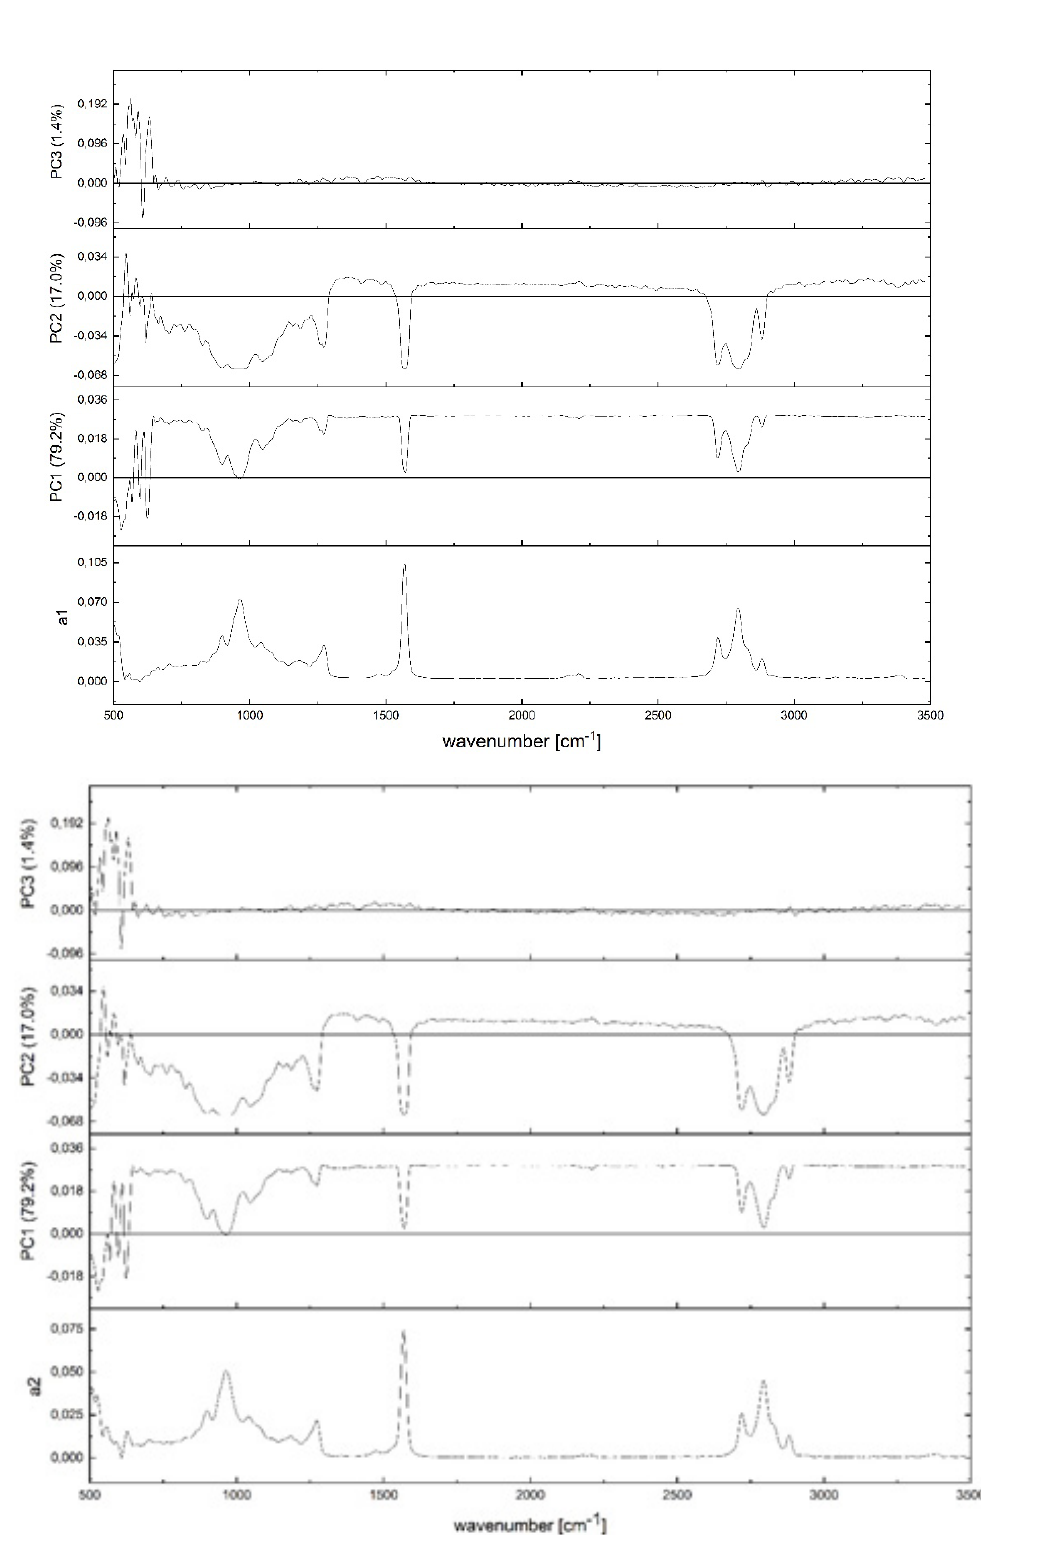
Figure 7: Loading plot of PC1, PC2, PC3 for the reference spectrum (a) a1 and (b)